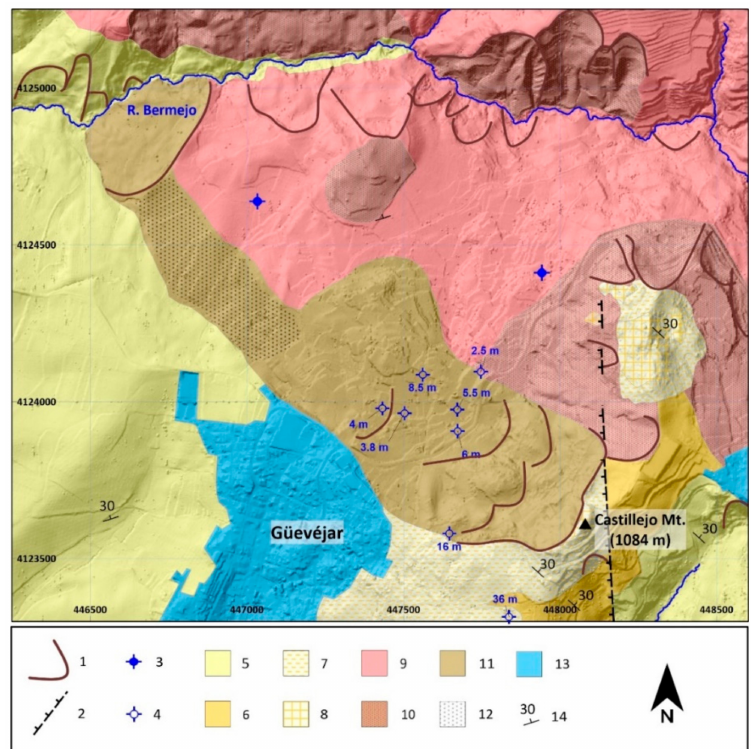
Figure 2. Geological map of the landslide area. ( 1 ) Landslide scarps, ( 2 ) faults, ( 3 ) springs, ( 4 ) well points and depth to water table (in m), ( 5 ) marls unit (MU unit), ( 6 ) red silts unit (RSU unit), ( 7 ) marls of the Marl and Limestone unit (MLU unit), ( 8 ) limestone of the Marl and Limestone unit (MLU unit), ( 9 ) red clays of the Recent Red Deposits unit (RRD unit), ( 10 ) other landslides, ( 11 ) Güev é jar landslide, ( 12 ) earth-flow in the Güev é jar landslide, ( 13 ) urban areas and ( 14 ) strike and dip of